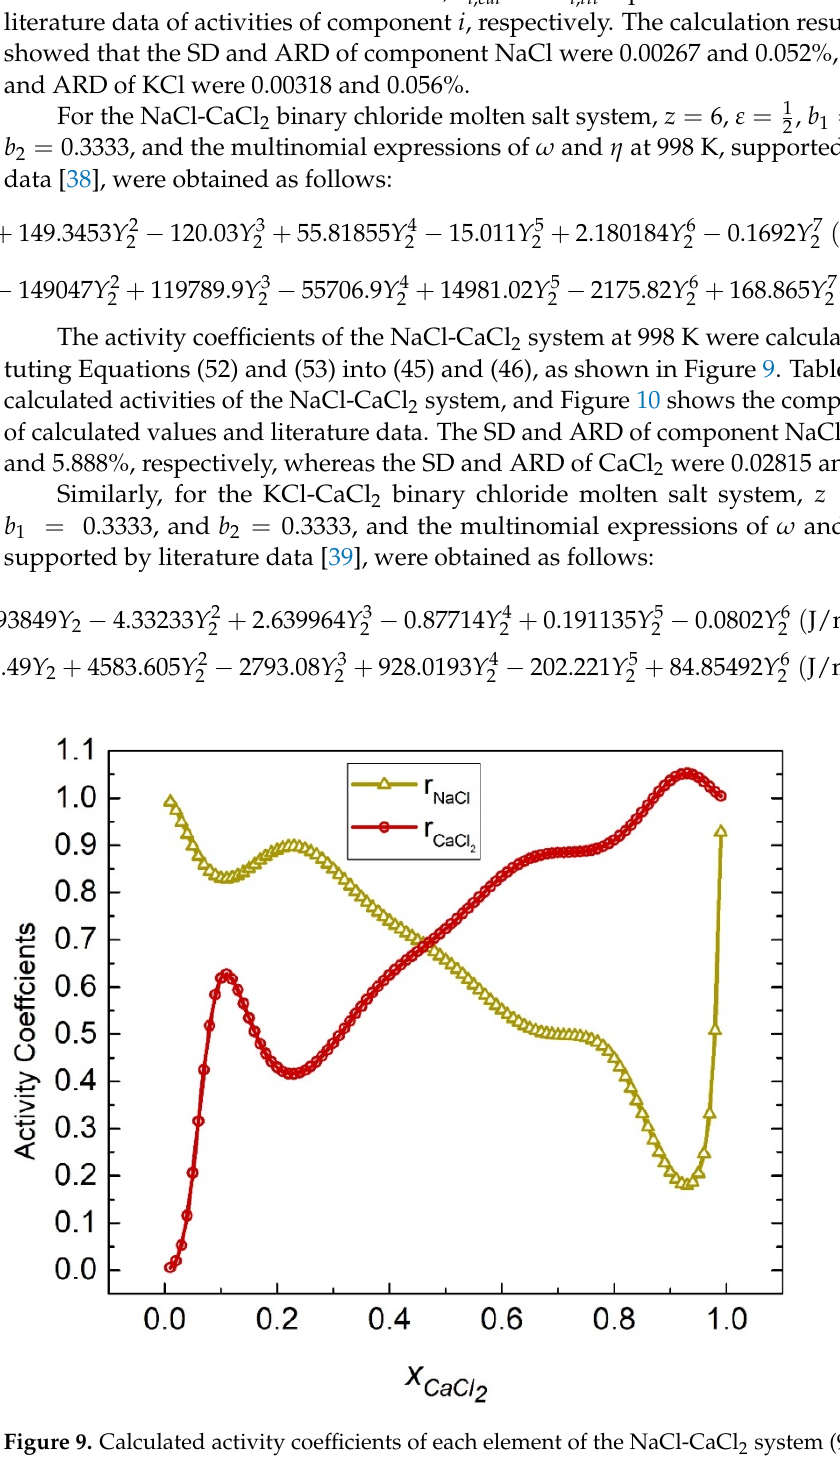
Figure 10. Comparison of the calculated activities and literature data of each element of the NaCl ‐ CaCl 2 system (998 K).